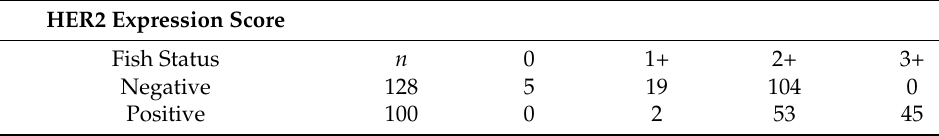
Table 1. Summary of the cohort of the different HER2